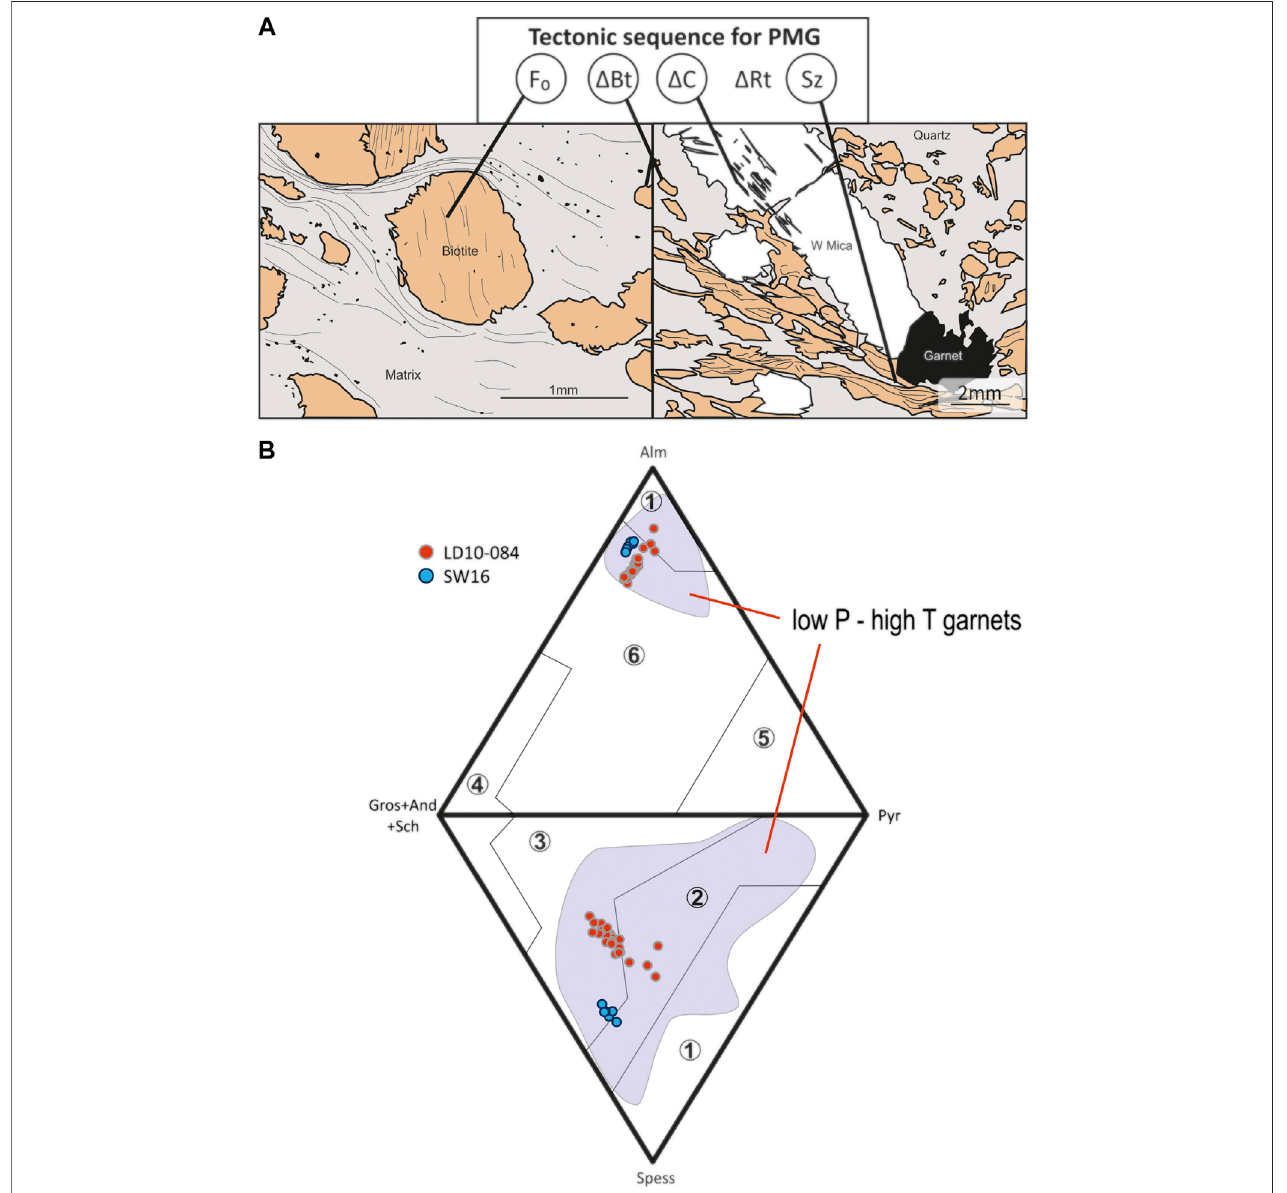
FIGURE 14 | (A) TectonicSequenceDiagramforthePinohMetamorphicGroup(PMG),illustratedbysketchesofthinsections.F 0 isearliestfabric, Δ Btisbiotitegrowth, Δ C is low pressure-high temperature metamorphism characterised by andalusite- and cordierite-bearing mineral assemblages, and Sz is shearing. (B) Double ternary garnet end-memberdiagramforgarnet-sillimaniteschistsamplesLD10-084andSW16ofthePinohMetamorphicGroup(afterSuggateandHall,2014).Garnetsinbothsamplesare spessartine-rich almandines. Shaded area shows garnets from low pressure-high temperature terranes for comparison (data from Suggate and Hall, 2014). Fields: 1) granites, 2) granulite and high-Mg pelites, 3) blueschists, 4) calc-silicates, skarns and rodingites, 5) ultrabasics, 6) basic rocks sub-ophiolites. ( Figure 9B ). Sample LD10-100 has K 2 O of 2.9 wt% which brings it into the high-K calc-alkaline fi eld. The samples are magnesian, calcic or calc-alkalic, and metaluminous (Frost et al., 2001; Figure 9C ). In the tectonic discrimination diagrams ( Figures 9D – F ) they plot in the unfractionated OTG (I & S-type) fi eld of Whalen et al. (1987) and clearly in the VAG fi eld (Pearce et al., 1984). With ASI (aluminium saturation index) values below 1.0 ( Figure 9F ) and relatively high Na 2 O ( > 3.1 wt%) the rocks are I-type granitoids. The trace